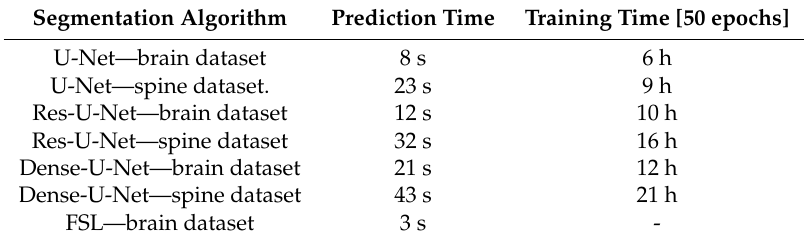
Table 3. Segmentation alogorithms comparison based on their computation time when ran on gtx 1080ti GPU.